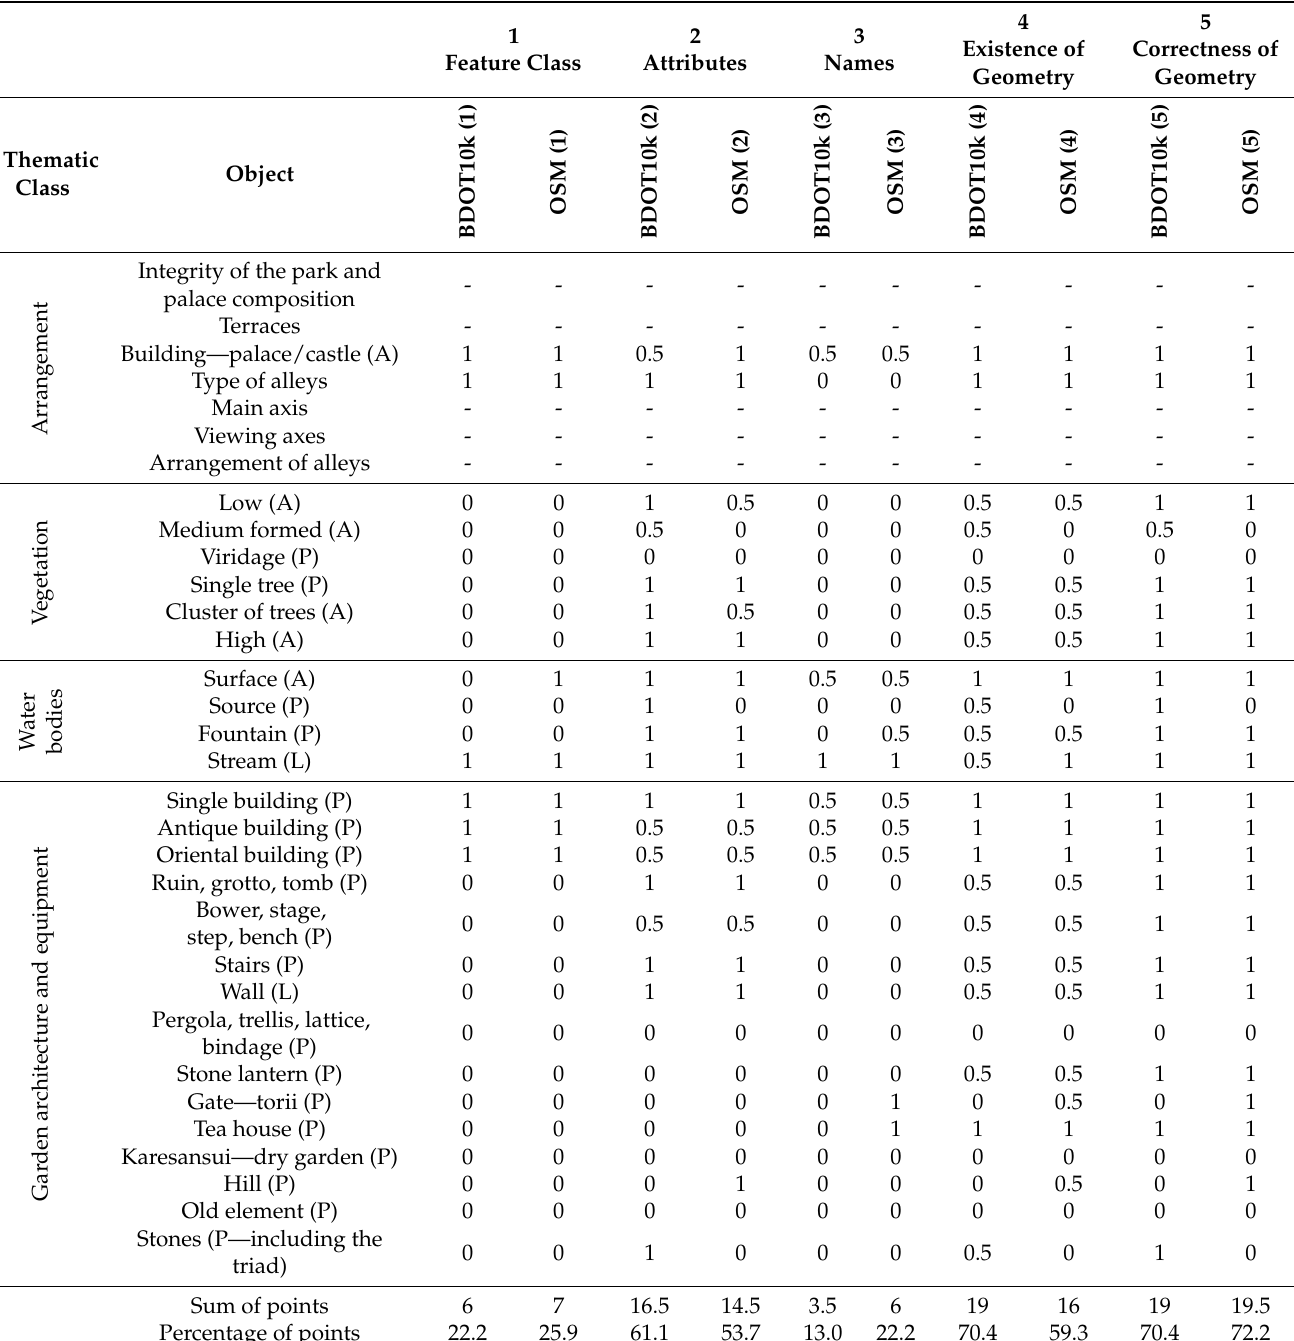
Table 1. OSM and BDOT10k data assessment ratings—the first level of map detail. P, L, A—type of geometry (point, line,